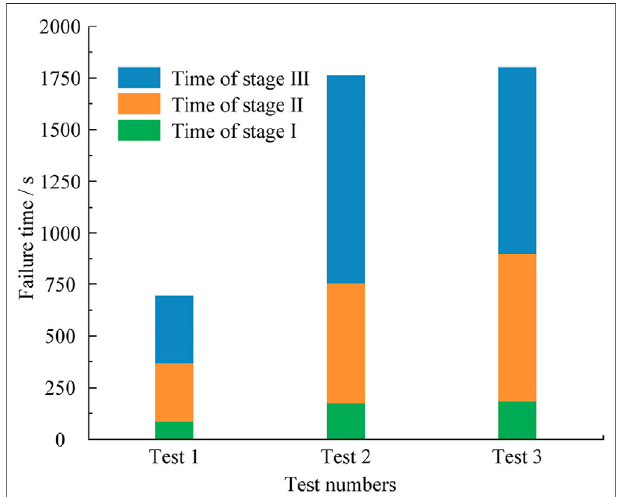
FIGURE 9 | Water level and discharge curve of Test No. 1.